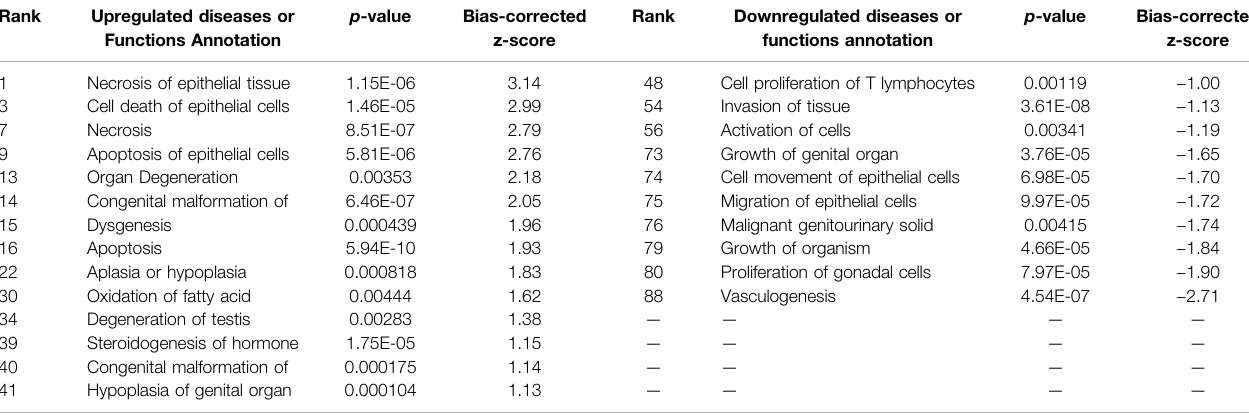
TABLE 1 | Ingenuity Pathway Analysis table of disease and Biological Functions from CDxCI DEGs ( p < 0.01, log fold change > 1/ < − 1). From “ Diseases or Functions Annotations ’’ column, after removing any redundancies, functions without a z-score, or a z-score between − 1 and 1. Mapped IDs: 9865; unmapped IDs: 4922.459 analysis-ready molecules: 214 upregulated and 245 downregulated. Ranked by z-score. Left: upregulated pathways. Right: downregulated pathways. Rank Upregulated diseases or Functions Annotation